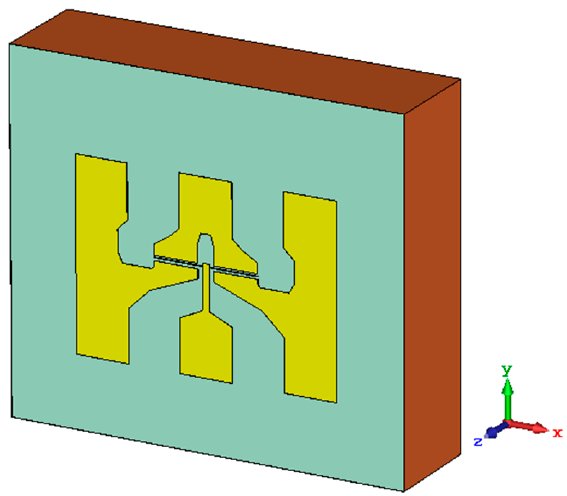
Figure 5. 3D view of the structure used in the simulation, the three spatial axis are shown. The vertical layout of the device defined in the model is the one presented in Figure 1a. The thickness of the gold layer used to fabricate the top electrodes and contact pads was 300 nm. A top passivation layer of SiO 2 with a thickness of 4 mm was added on top of the metallization layer. In simulations it is assumed that the simulated structure (Figure 5) was surrounded by air. Four values of L g were studied (0.50, 0.25, 0.15, and 0.10 µ m) in order to investigate if the transistor gate itself has a significant impact on the coupling of THz radiation to the channel.